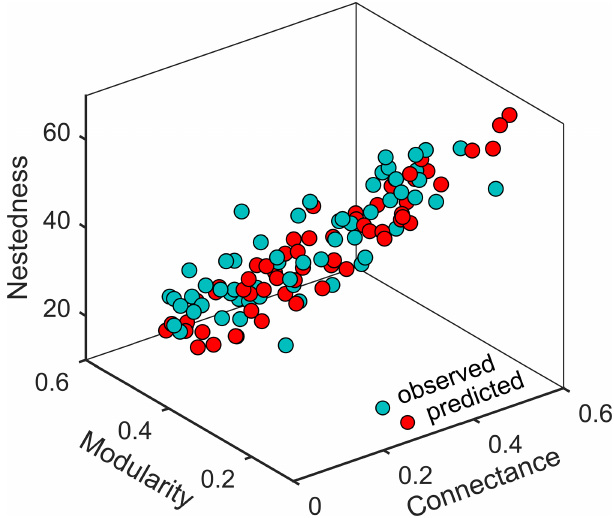
Fig 1. Predicted vs. observed network architecture. For each network, simulations were run to equilibrium and its architecture(modularity, nestedness, and connectance) recorded. Predictionsare the averages of the last 200 time units after the